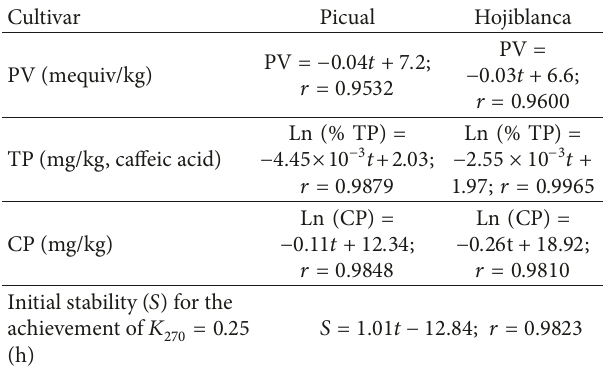
Table 4: Correlations between storage time 𝑡 (in days) and selected parameters by Guti´errez and Fern´andez